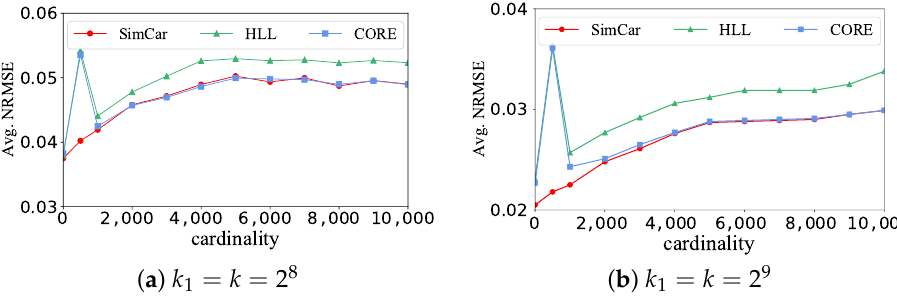
Figure 5. User cardinality estimation errors of our framework, SimCar, compared with HLL and CORE.